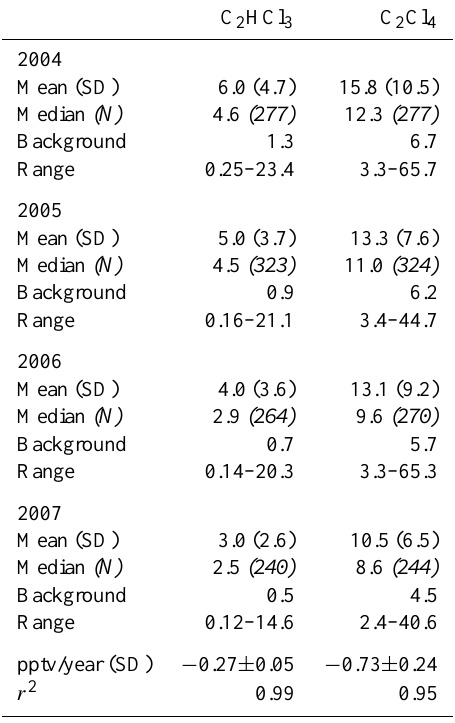
Table 2. Annual C 2 HCl 3 and C 2 Cl 4 statistics (pptv) for 2004– 2008, and the rate of decrease (pptv/year) in the annual background mixing ratios ± standard deviation (SD). N is the number of sam- ples. Background is the 10th percentile for the entire